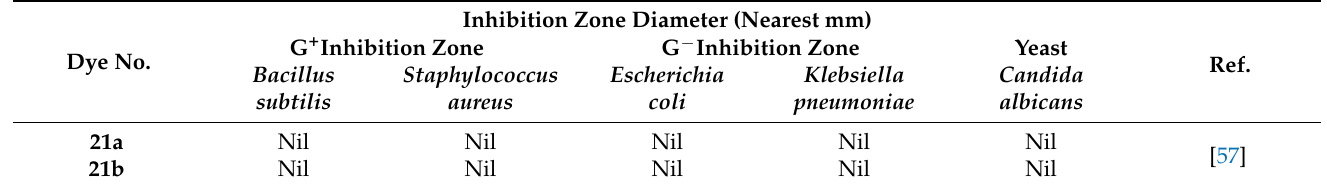
Table 7. Antimicrobial activity of the dyed polyester fabrics with disperse dyes 21a and 21b. Inhibition Zone Diameter (Nearest mm) Dye No.